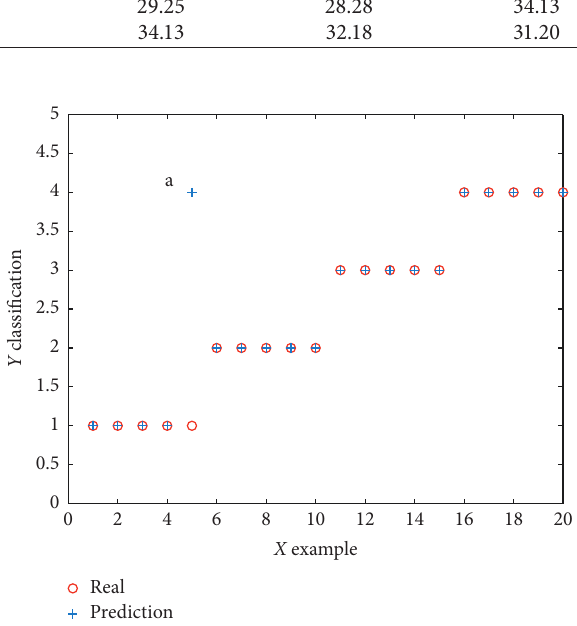
Figure 10: The fitting diagram of